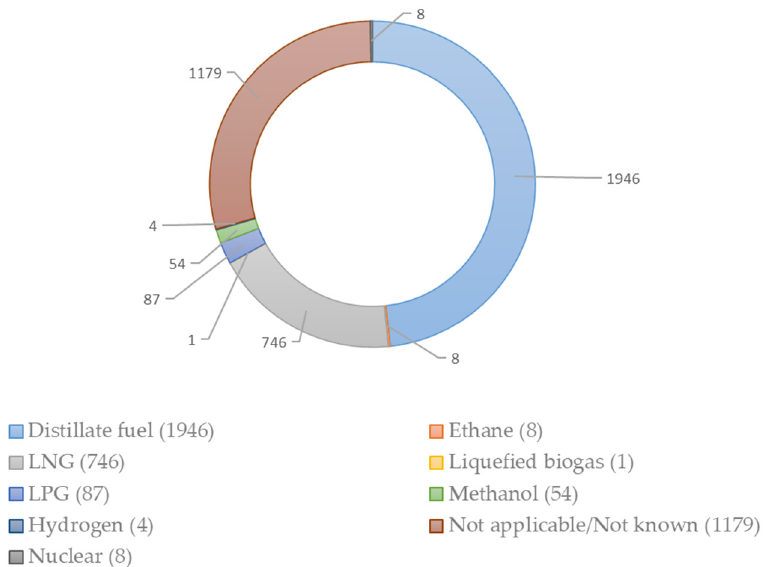
Figure 9. Classification of newbuildings * vessels (more than 500 DWT) per “Fuel Type 1” from IHS Markit. Data obtained from IHS Markit [56]. * Includes the following subcategories: Keel Laid, Launched, On Order/Not Commenced, Projected, and Under Construction. Note: under category Nuclear, the vessel type is submarine.